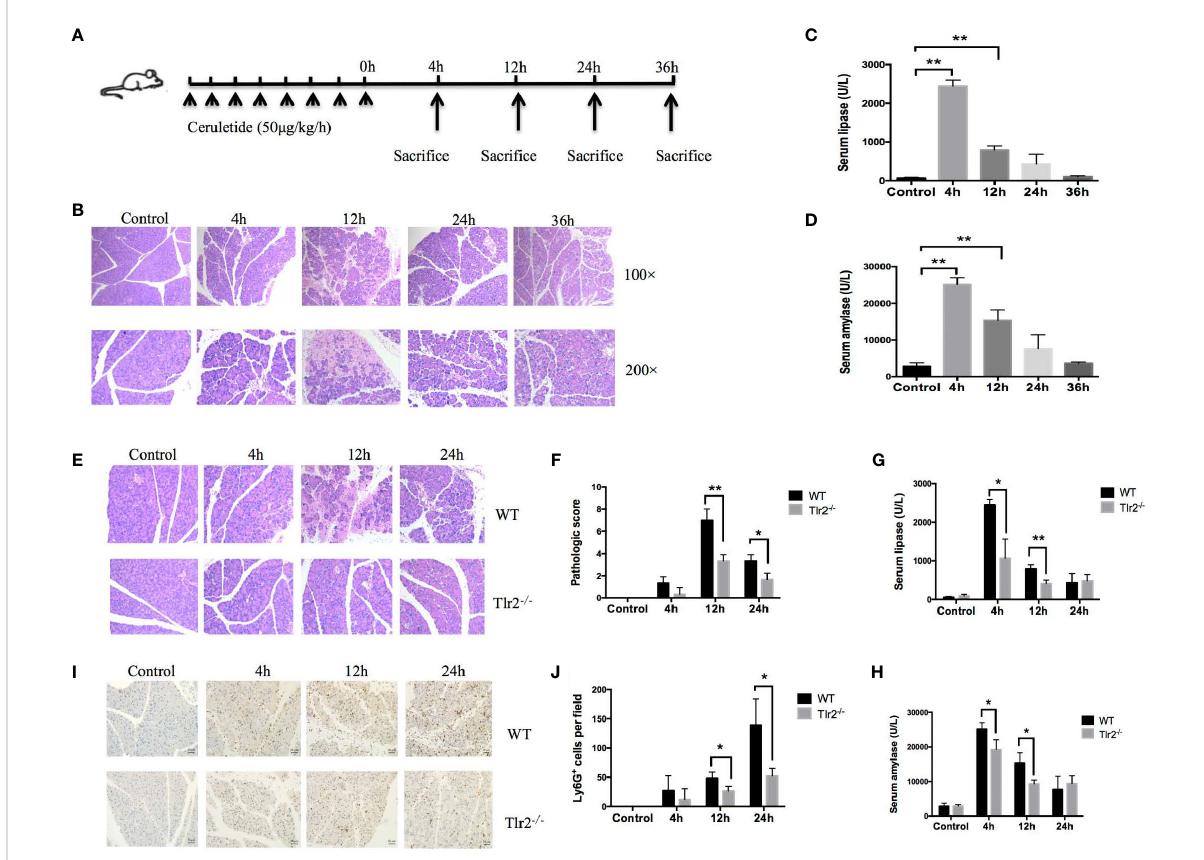
FIGURE 6 Tlr2 de fi ciency alleviated pancreatic in fl ammation in a cerulein-induced AP mouse model. (A) Illustration of the experimental protocol. (B) Histological analysis of mouse pancreases in the cerulein-induced acute pancreatitis mouse model (original magni fi cation, 100× or 200×). (C, D) Serum lipase and amylase were detected in a cerulein-induced acute pancreatitis mouse model. (E) H&E staining of pancreas samples from wild-type (WT) and Tlr2 -/- mice (original magni fi cation, 200×). (F) Pancreas injury scores were evaluated based on H&E staining. (G, H) Serum lipase and amylase levels in the WT and Tlr2 -/- groups are displayed. (I) Immunostaining for neutrophils was performed. The sections were stained for Ly6G to con fi rm the in fi ltration of neutrophils in the pancreas (original magni fi cation, 200×). (J) The numbers of Ly6G + cells were counted based on immunostaining. Data are shown as the mean ± SD ( n = 3/group). These data are representative of three independent experiments. * P < 0.05; ** P <